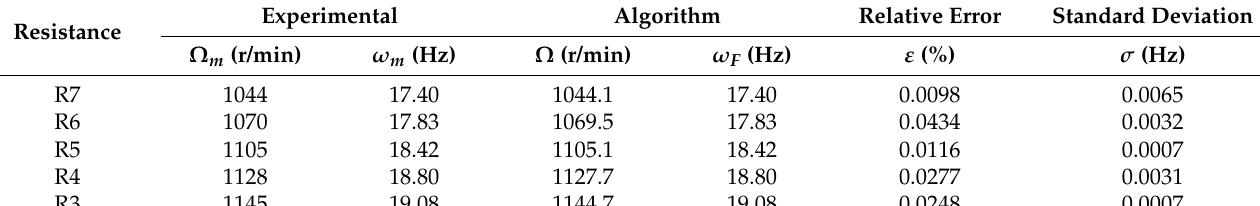
Table 11. DC generator coupled to the motor shaft: estimated speeds and frequencies, relative errors, and standard deviations for load tests at 20